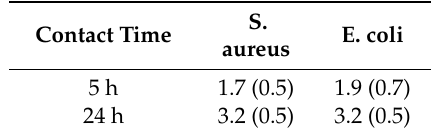
Table 2. Microbicidal e ff ect (ME) values 1 for CuS NP-glass